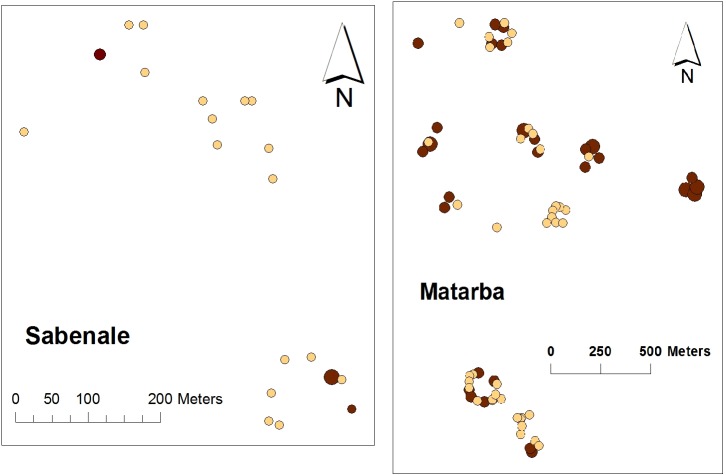
Map of the distribution of RVFV seropositives for study villages Sabenale and Matarba.Within each village, circles represent the location of study subjects’ households. Darker shaded circles indicate houses with RVFV seropositive residents. Larger circles indicate that > 50% of residents were seropositive.